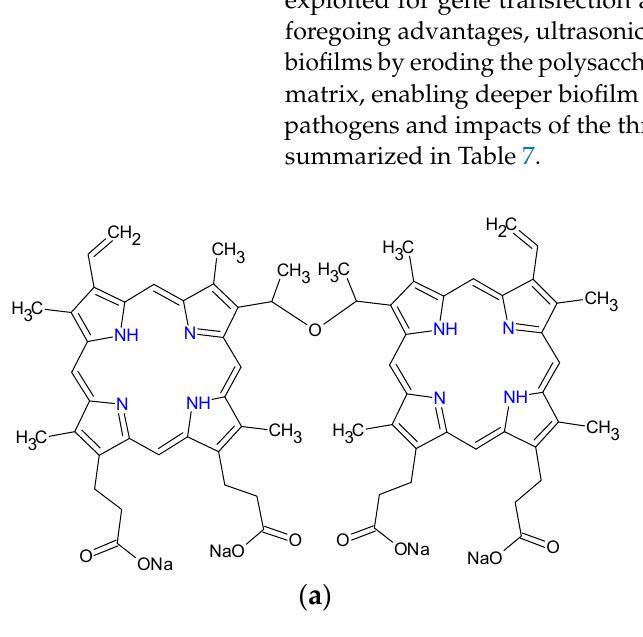
Figure 3. Chemical structures of sinoporphyrin sodium ( a ) and protoporphyrin IX ( b ).